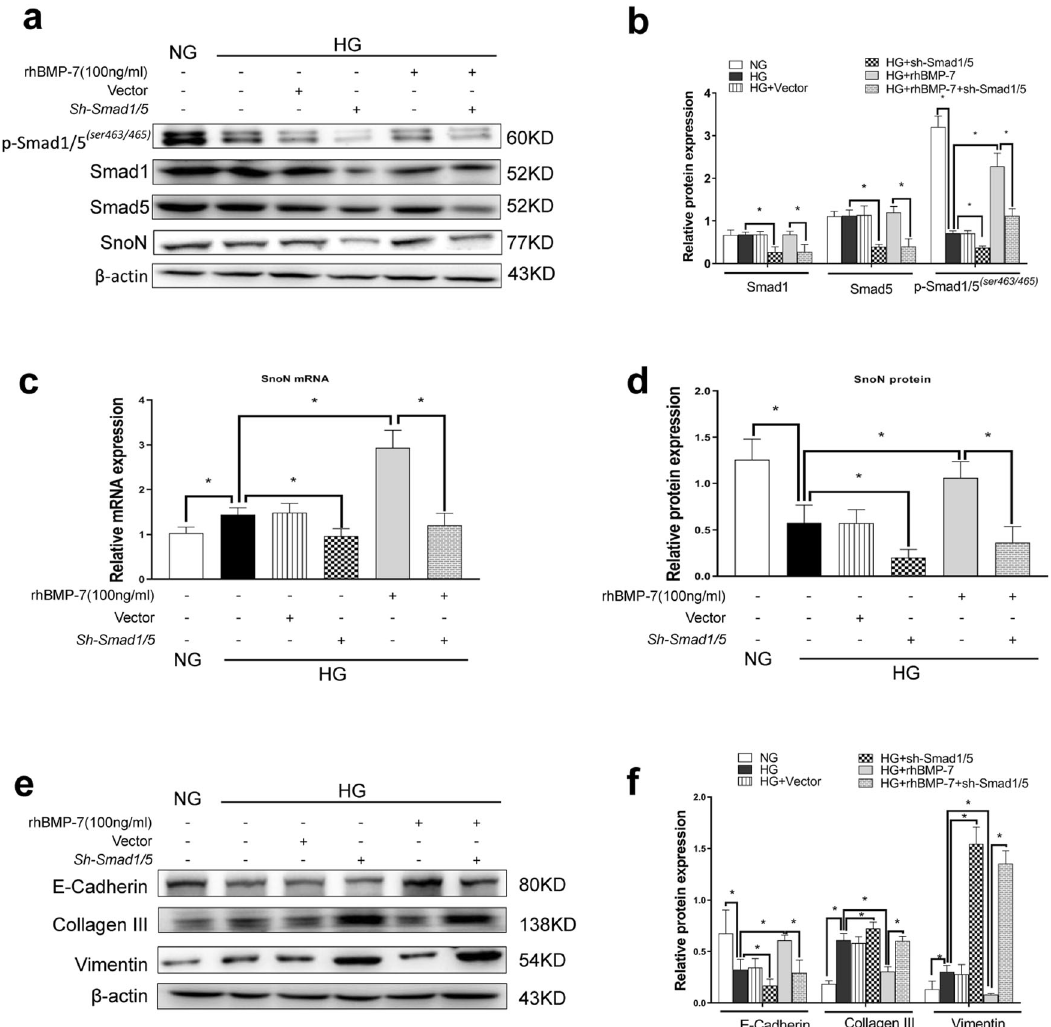
Fig. 6 Inhibition of Smad1/5 expression lessened BMP-7 induced SnoN protein and the renoprotection of BMP-7 in renal tubular interstitial fi brosis. Knockdown Smad1/5 by transfection of Smad1/5shRNA(sh-Samd1/5) plasmid. Representative a Western blot and quantitative data were revealed the expression of b p-Smad1/5 (ser463/465) , Smad1, Smad5, and d SnoN in NRK-52E cells under different conditions. c Graphical presentations show the relative abundance of SnoN mRNA after normalization with β -actin mRNA analyzed by RT-qPCR. Representative e Western blot and f quantitative data were revealed the expression of E-cadherin, Collagen-III, and Vimentin in NRK- 52E cells under different conditions, * P < 0.05 ( n =